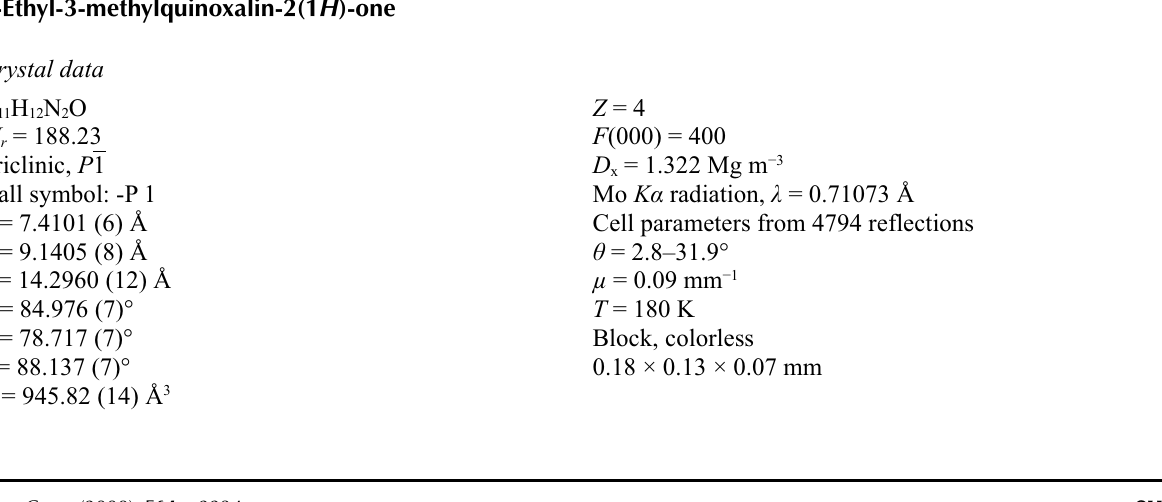
Figure 2 A partial packing diagram. Hydrogen bonds are shown as dashed lines [symmetry code: (′) -x, -y, -z]. 1-Ethyl-3-methylquinoxalin-2(1 H